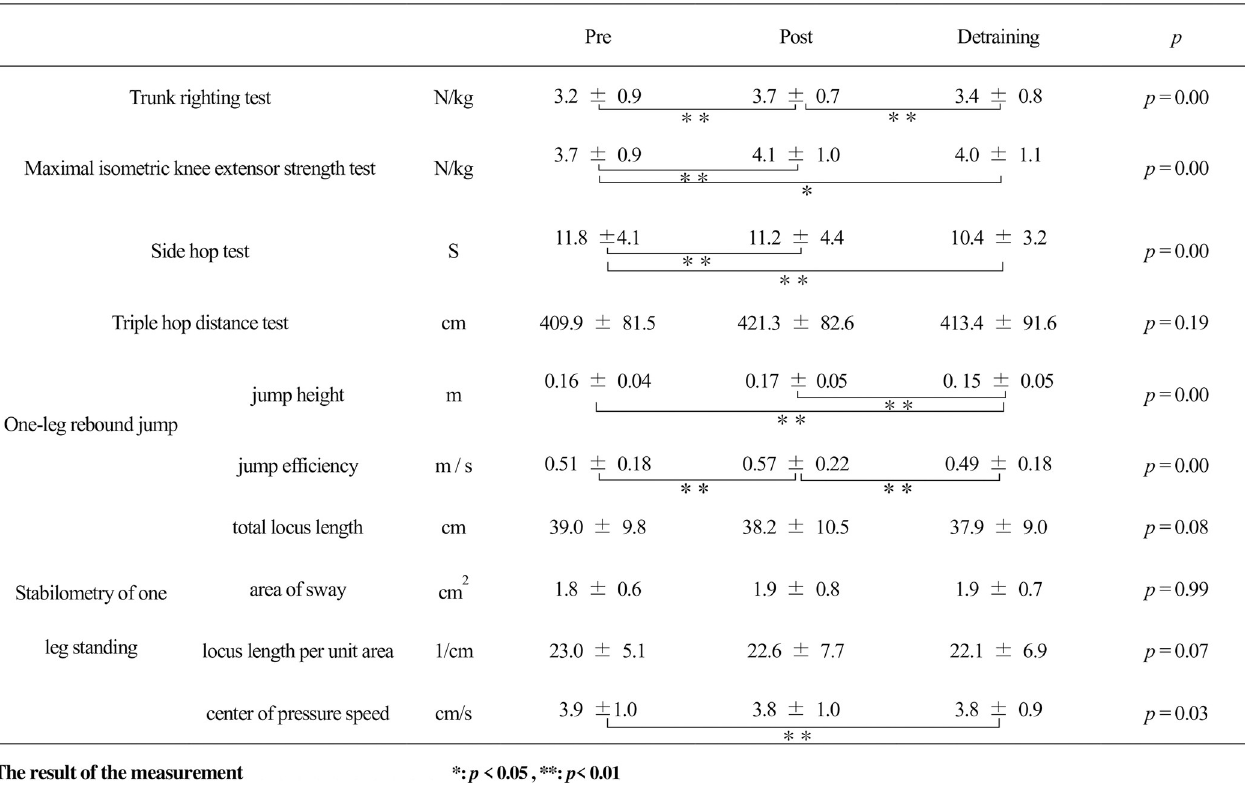
Fig 5. The result of the